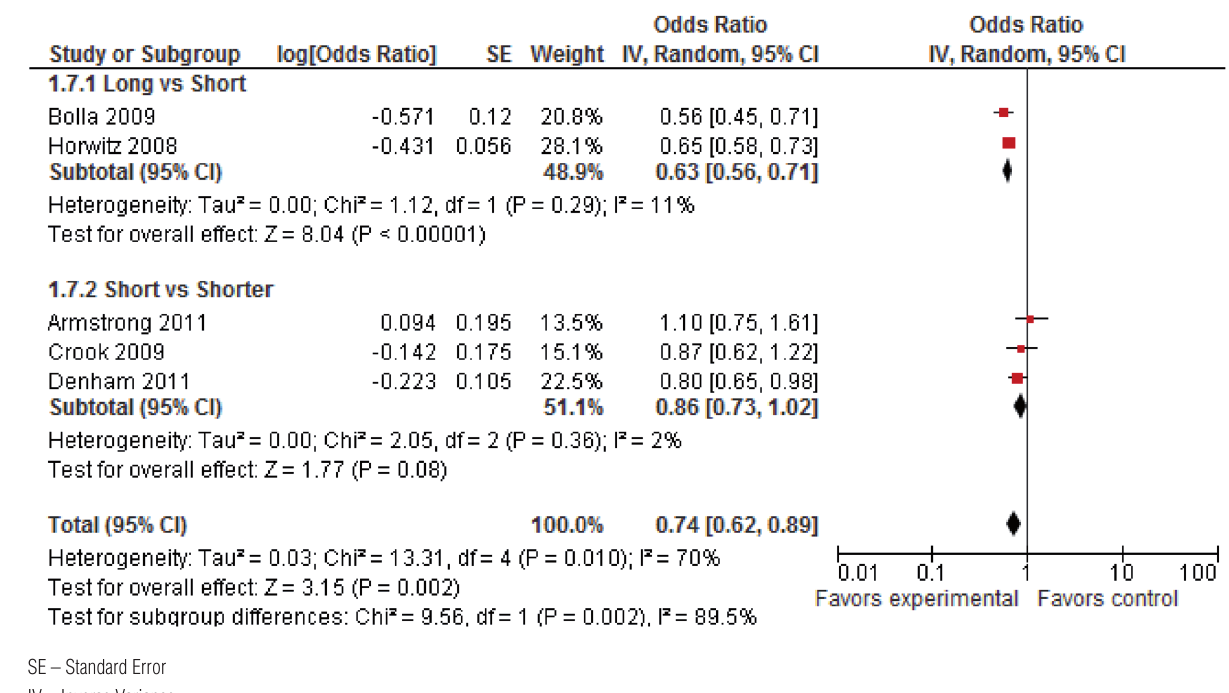
Figure 3 - Disease-free Survival – Pooled